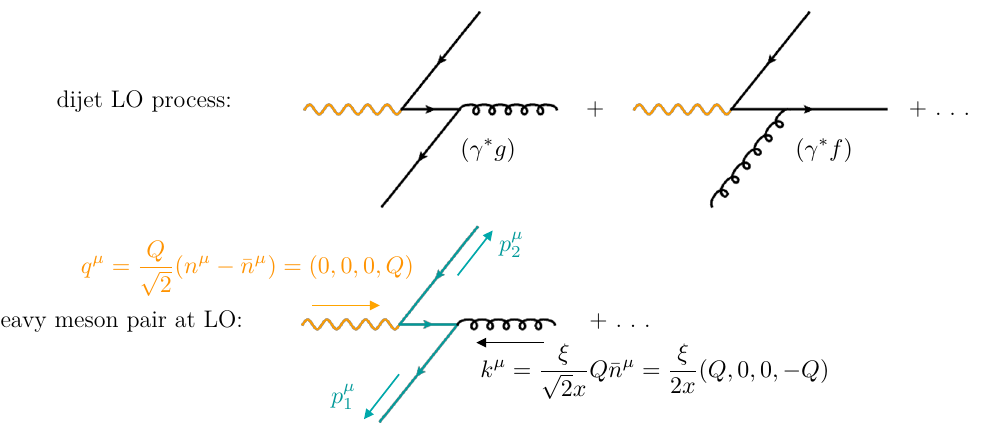
Figure 1 . Example LO diagrams for the two processes. The momenta q (cid:22) and k (cid:22) (corresponding to the photon and incoming parton momenta respectively) are expressed in the Breit